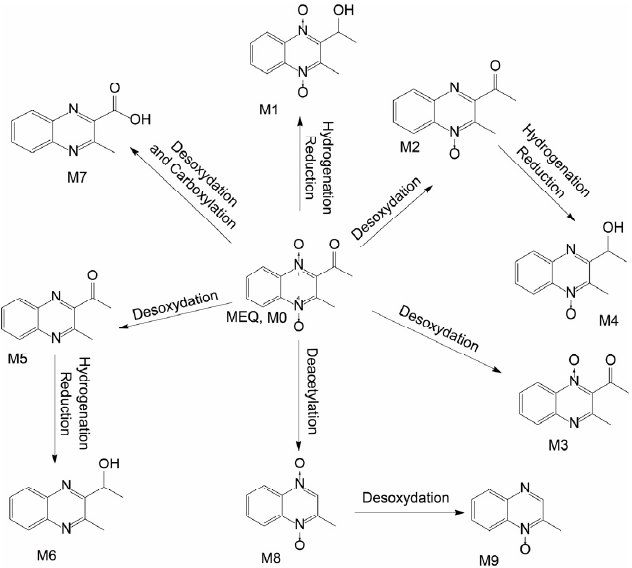
Figure 4. Proposed metabolic pathways of MEQ and metabolites in sea cucumber in vivo (hydro- genation reduction, deoxidation, carboxylation, deacetylation, and combinations thereof).